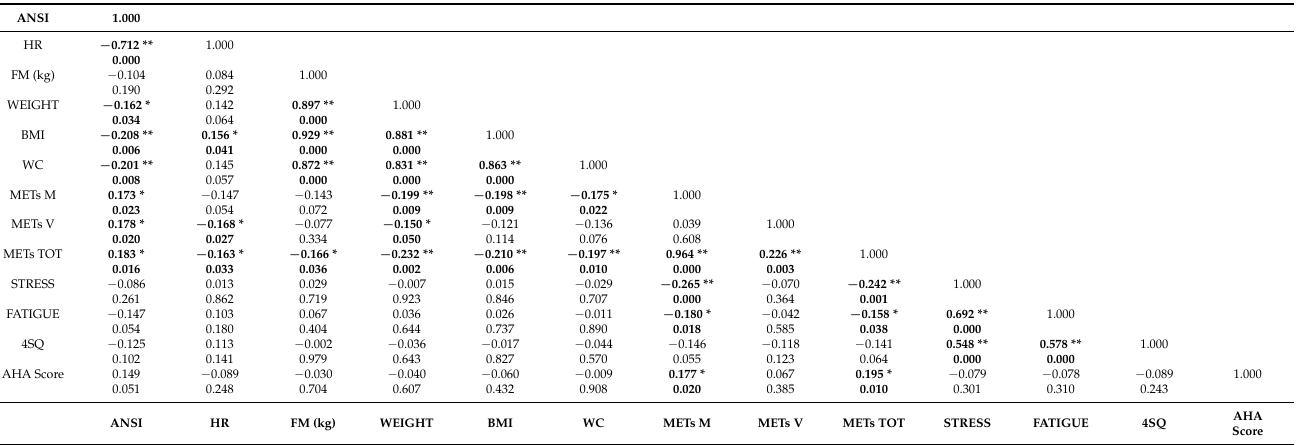
Bold values indicate significant correlations. * Correlation is significant at the 0.05 level (two-tailed). ** Cor- relation is significant at the 0.01 level (two-tailed). Abbreviations: ANSI = autonomic nervous system index; HR = heart rate; FM = fat mass; BMI = body mass index; WC = waist circumference; MET = metabolic equiv- alent; M = moderate; V = vigorous; TOT = total activity volume; 4SQ = Subjective Somatic Stress Symptoms Questionnaire; AHA Score = American Heart Association Diet